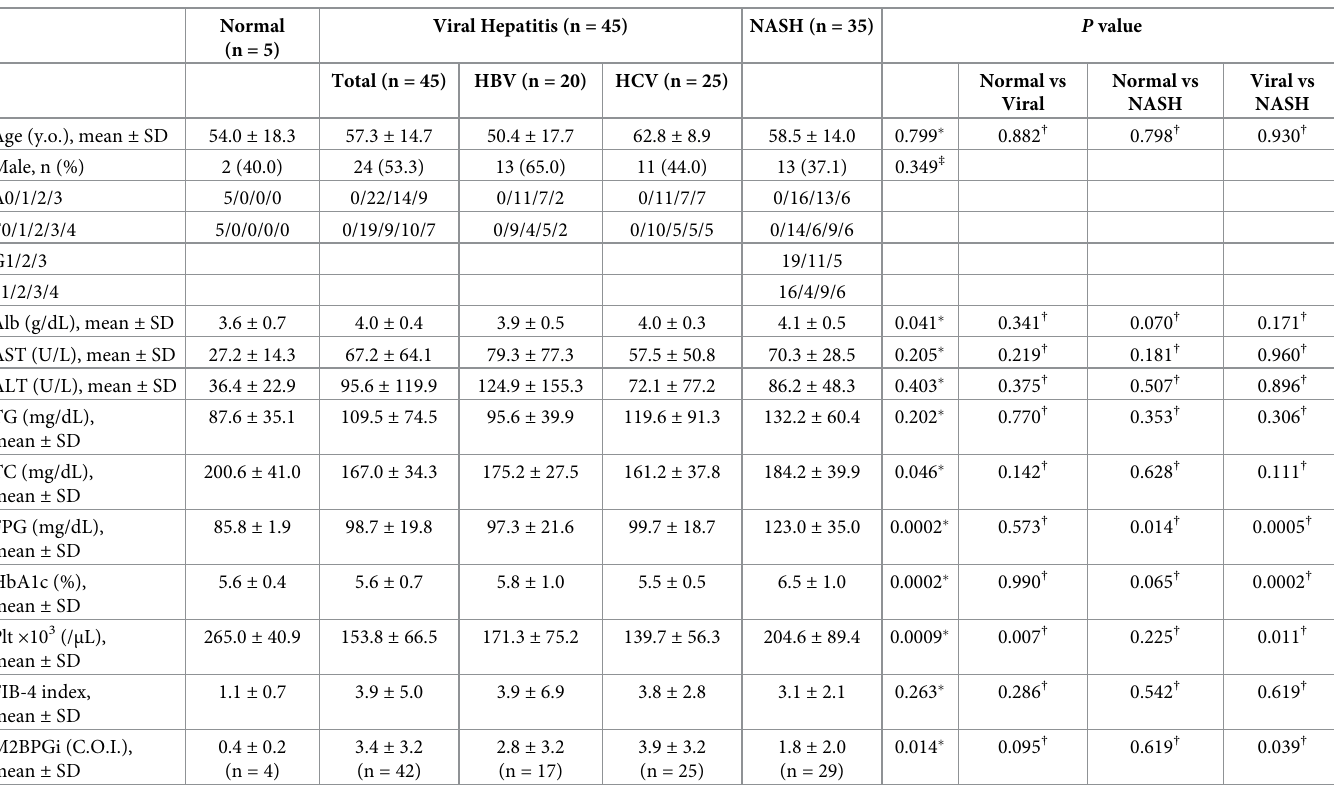
Table 1. Patient